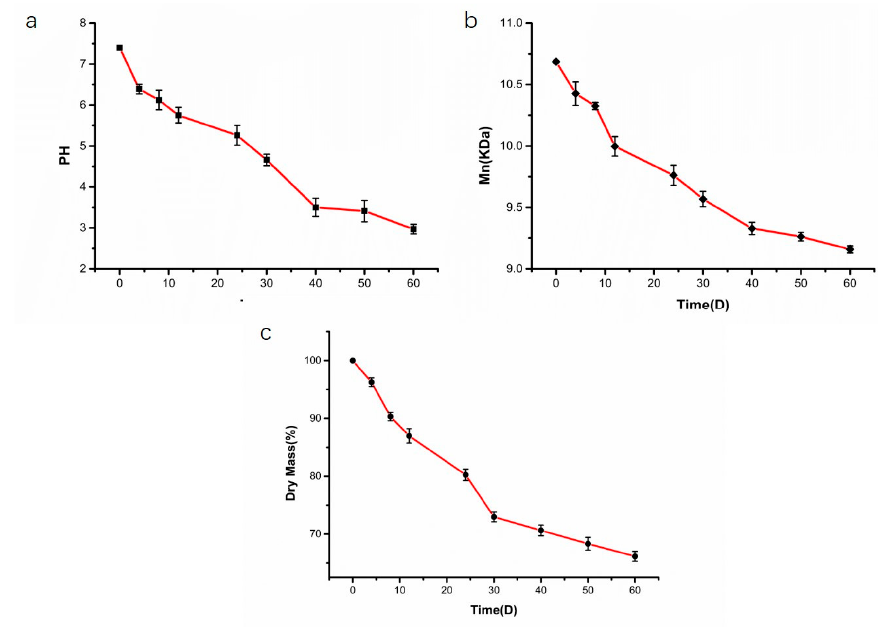
Figure 5. Changes of pH ( a ), Mn ( b ) and dry weight loss ( c ) during degradation of